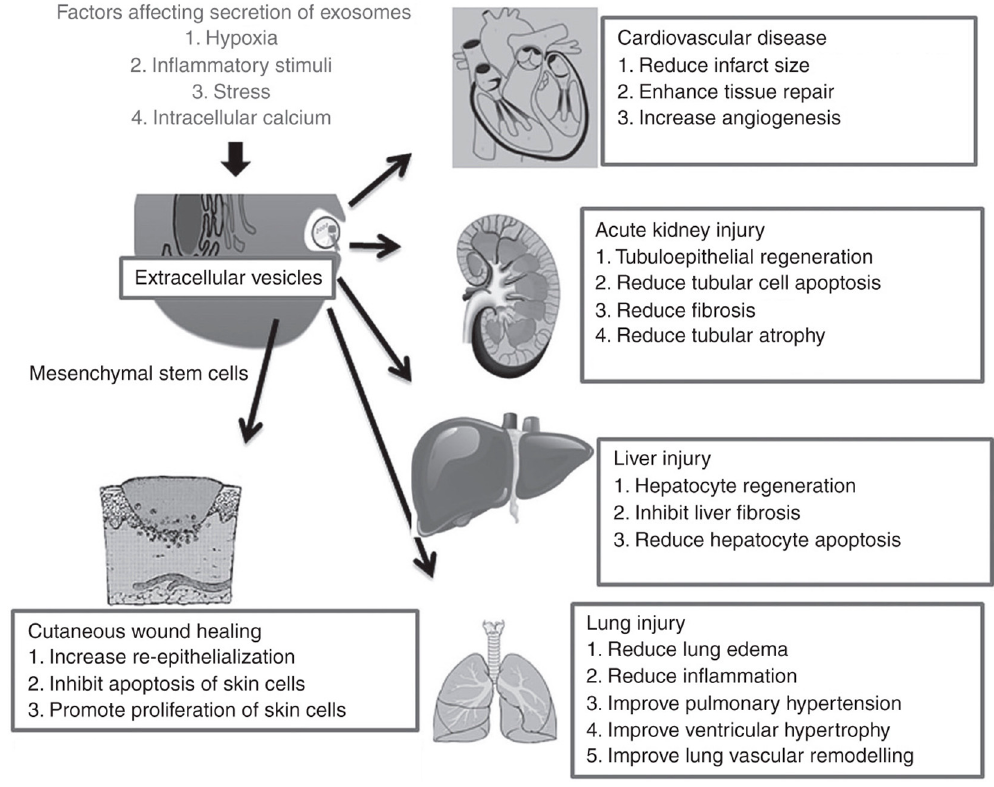
Figure 2. Effects of extracellular vesicles in a variety of regenerative medicine applications [35]. MSC-derived EVs in particular have shown therapeutic benefits by promoting repair and regeneration in numerous tissue types, including the heart, kidney, liver, lung and skin. Reproduced with permission from [35].